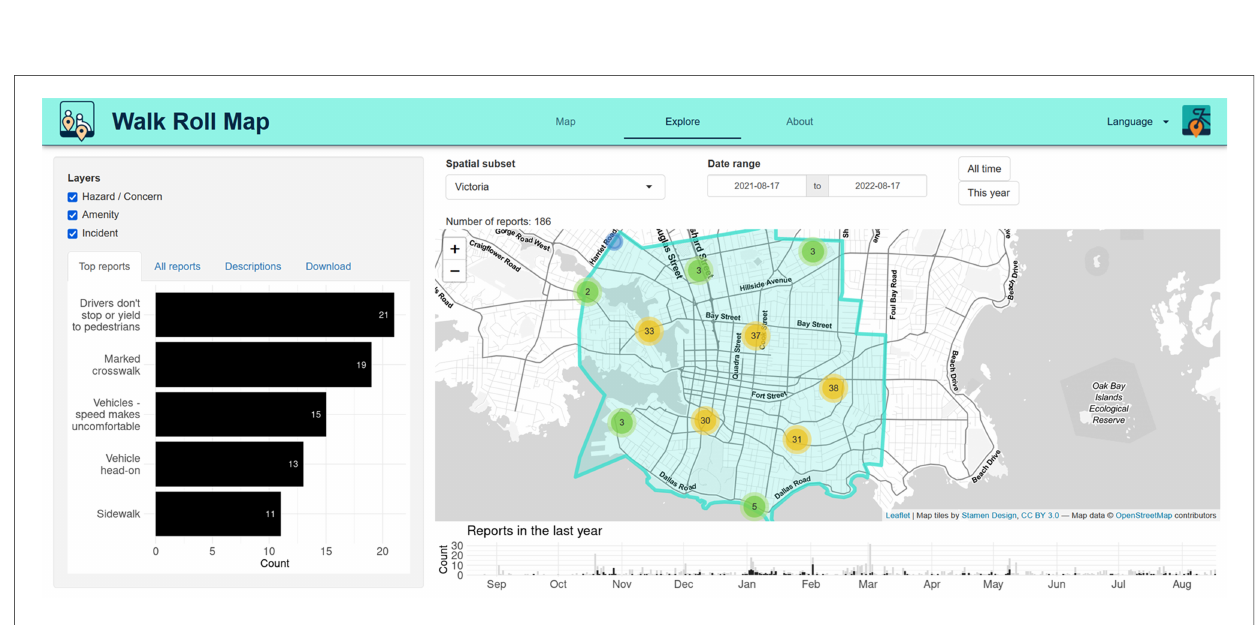
FIGURE 6 Example of visualization of WalkRollMap.org data for Victoria, British Columbia,